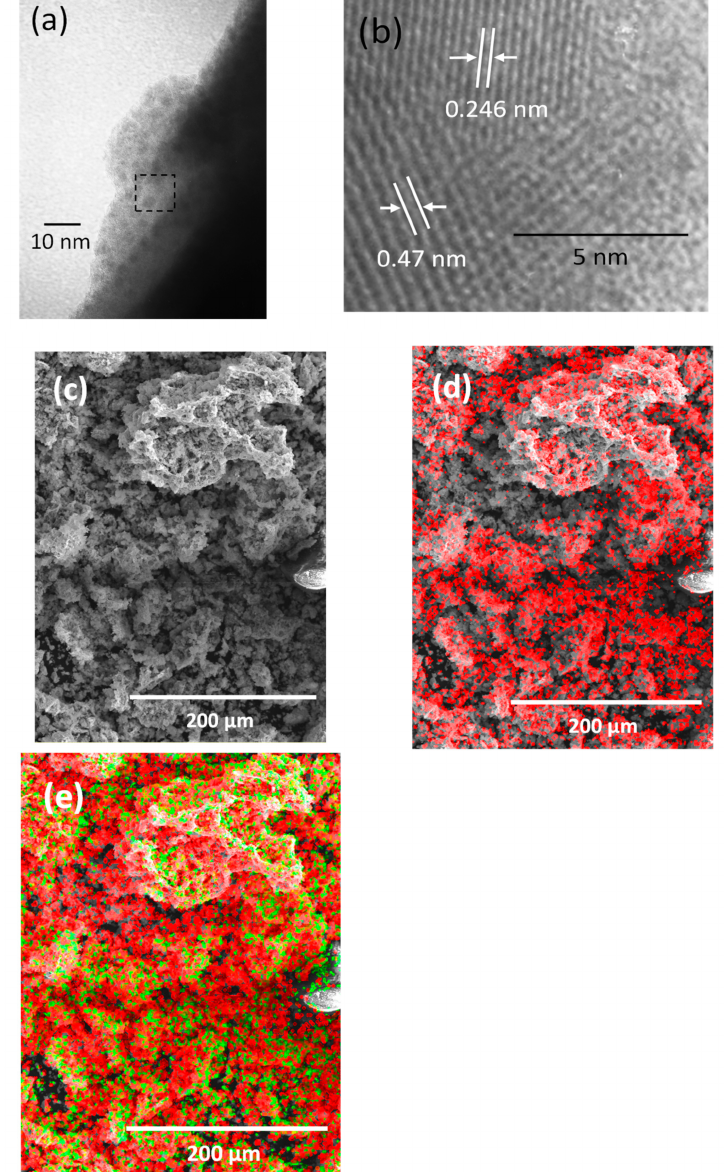
Figure 3. ( a , b ) HRTEM and ( c ) SEM figures of 1.00CoP/BiVO 4 photocatalyst. SEM/EDS figures showing the distribution of ( d ) P and ( e ) Co (red symbols) and P (green